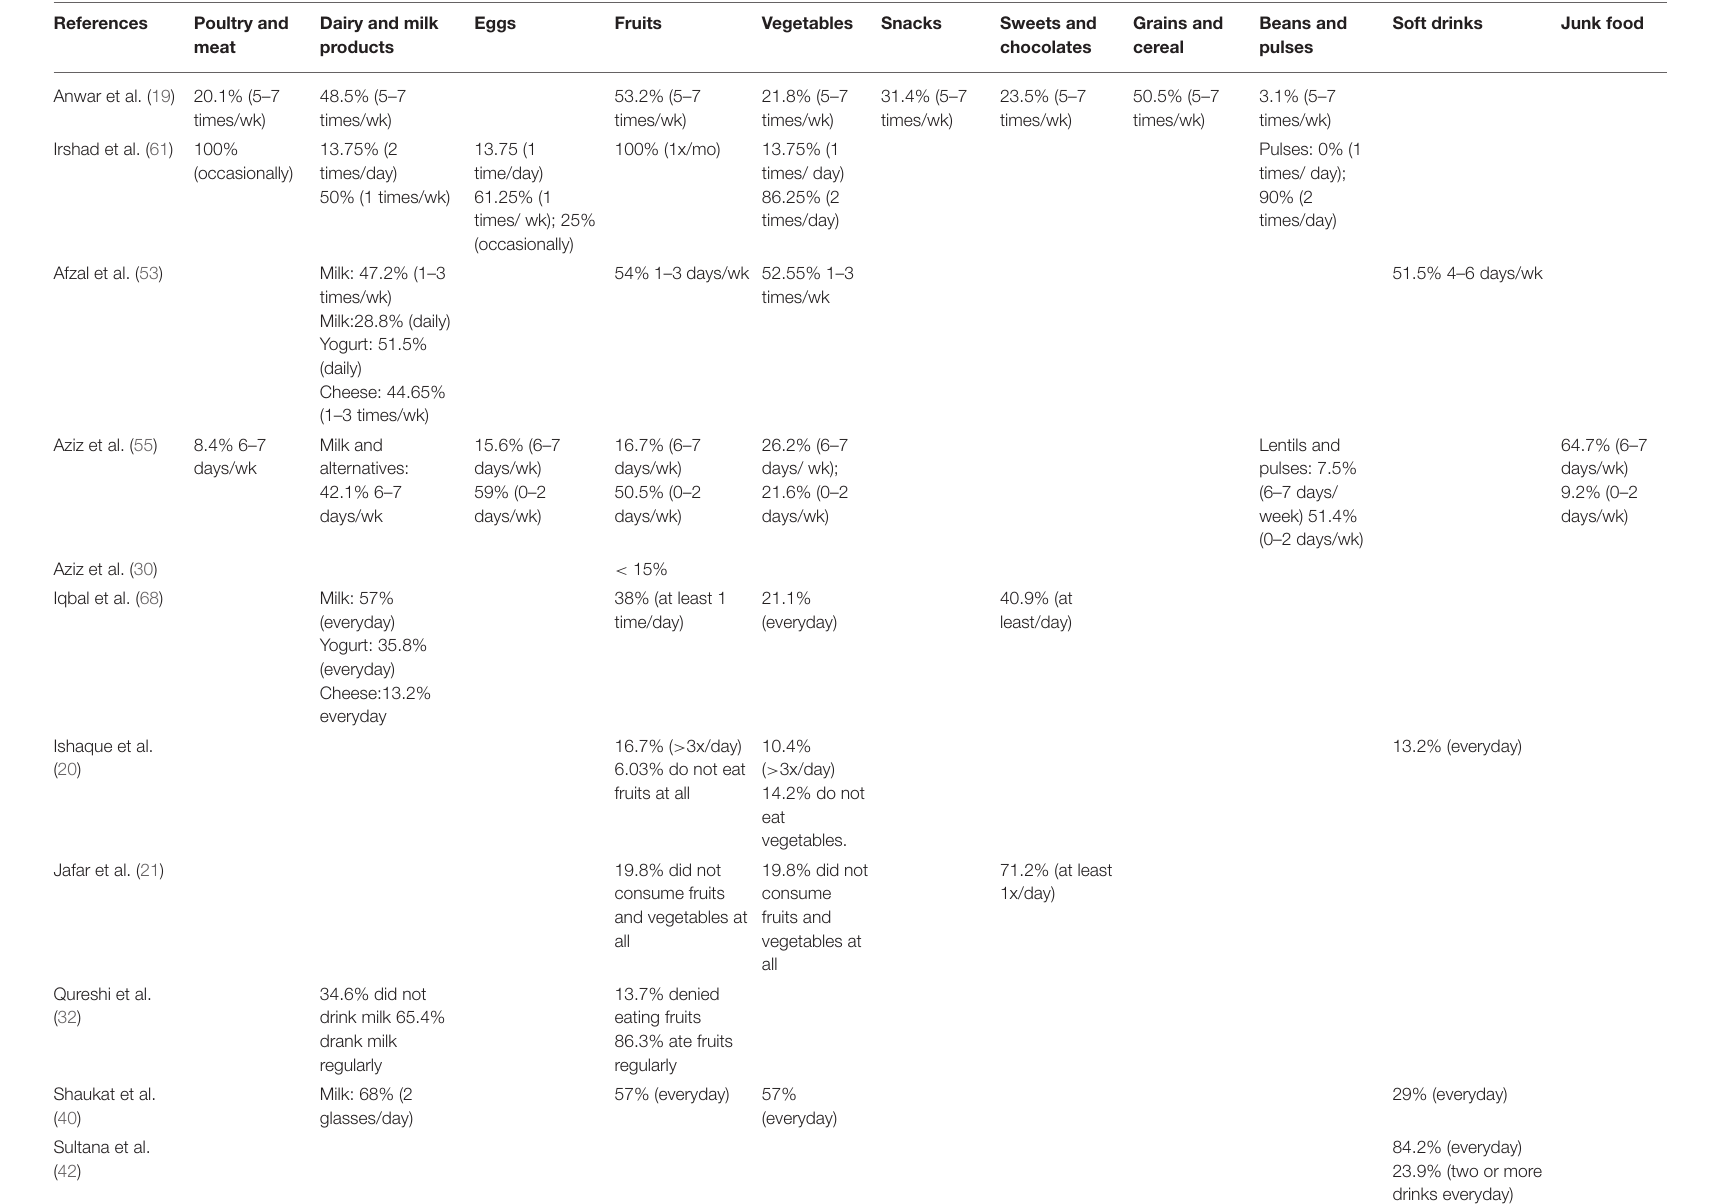
TABLE 5 | Dietary intake